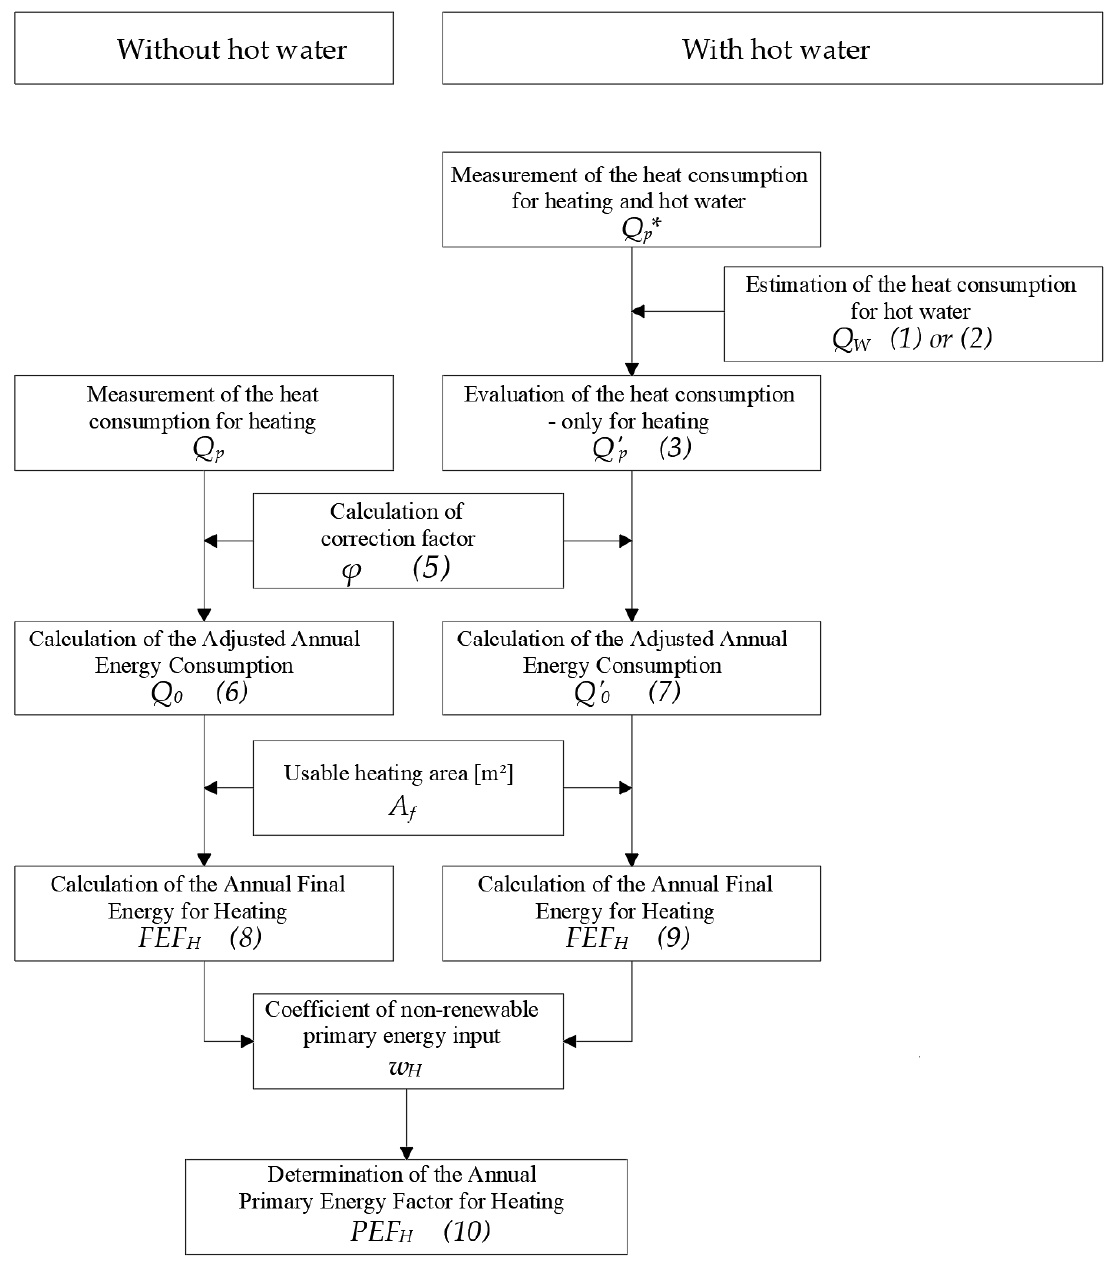
Figure 1. Block diagram of the calculation algorithm (numbers of formulas and explanation of the symbols presented below).